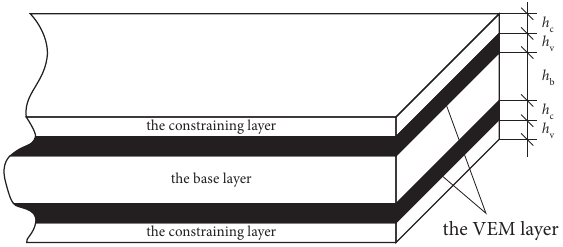
Figure 3: CLD structure with two constrained VEM